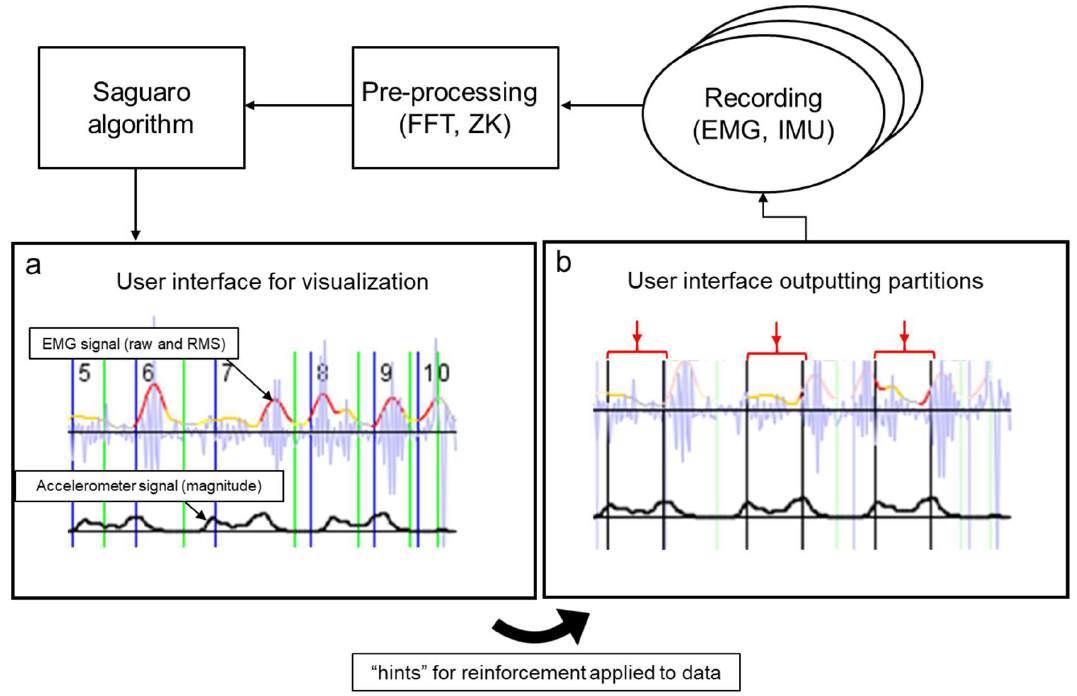
Figure 1. AI tool workflow for implementation and training utilizing the Saguaro algorithm, user feedback and reinforcement learning. Panel 1 ( a ) depicts the unsupervised partitions (5–10, green and blue vertical lines) from the Saguaro algorithm on the EMG and accelerometer signal. RMS = root-mean-square error. Panel 1 ( b ) depicts the final partitions after reinforcement learning on the EMG and the accelerometer signal (red arrows indicate swing phases).